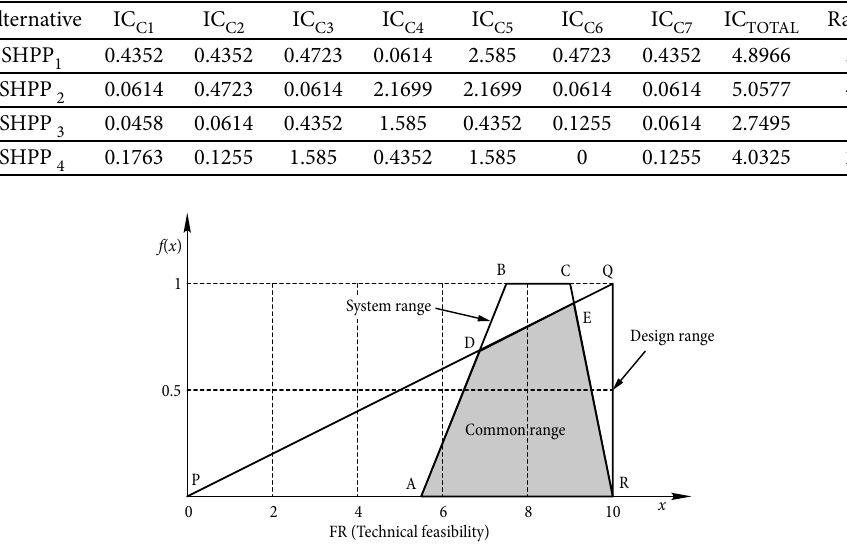
Table 3. Selection and ranking of SHPPs Alterna tive